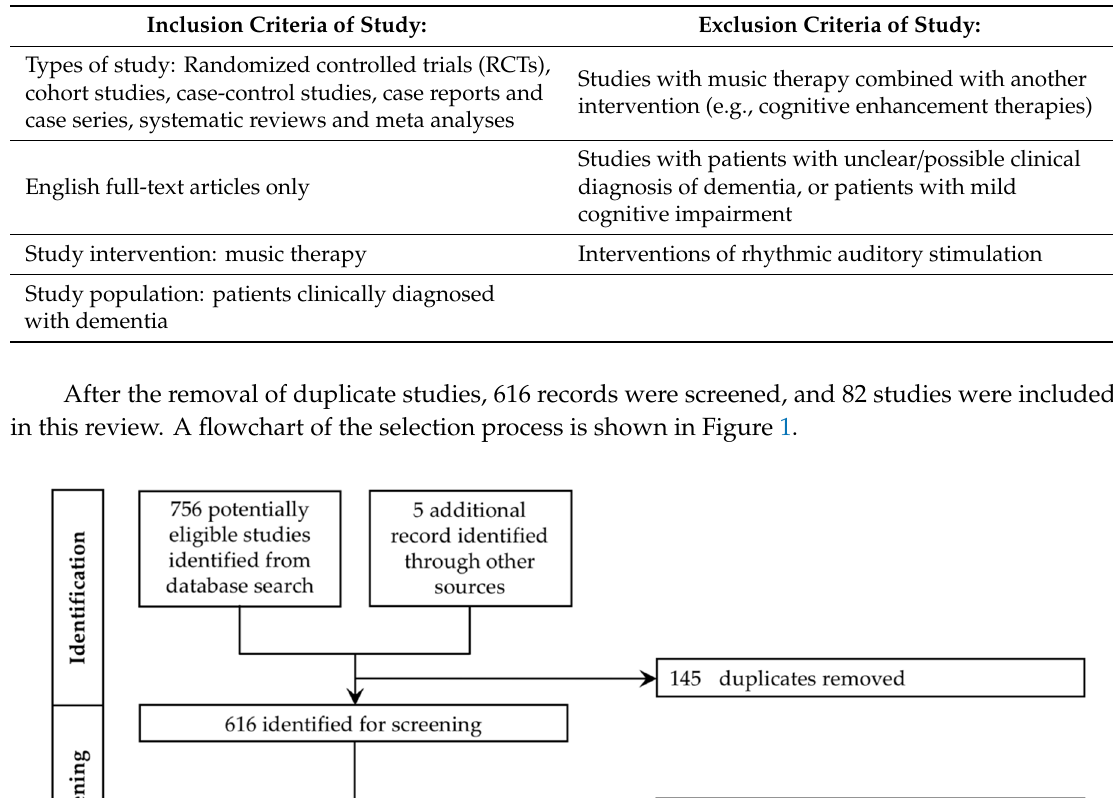
Table 2. Inclusion and exclusion criteria of studies.